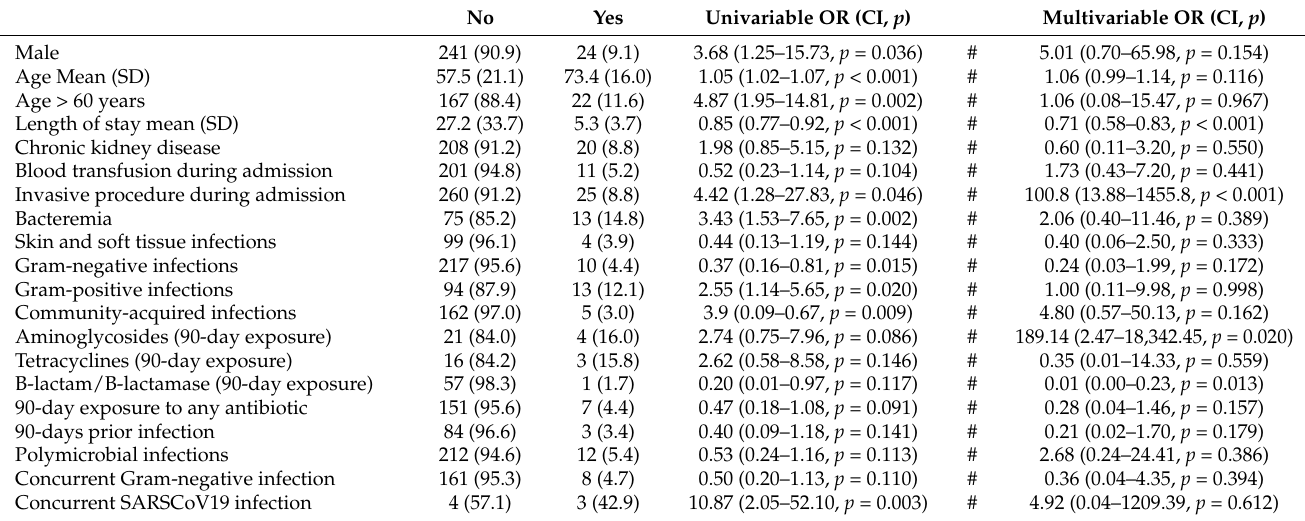
Table 3. Predictors for infection-related 14-day mortality.